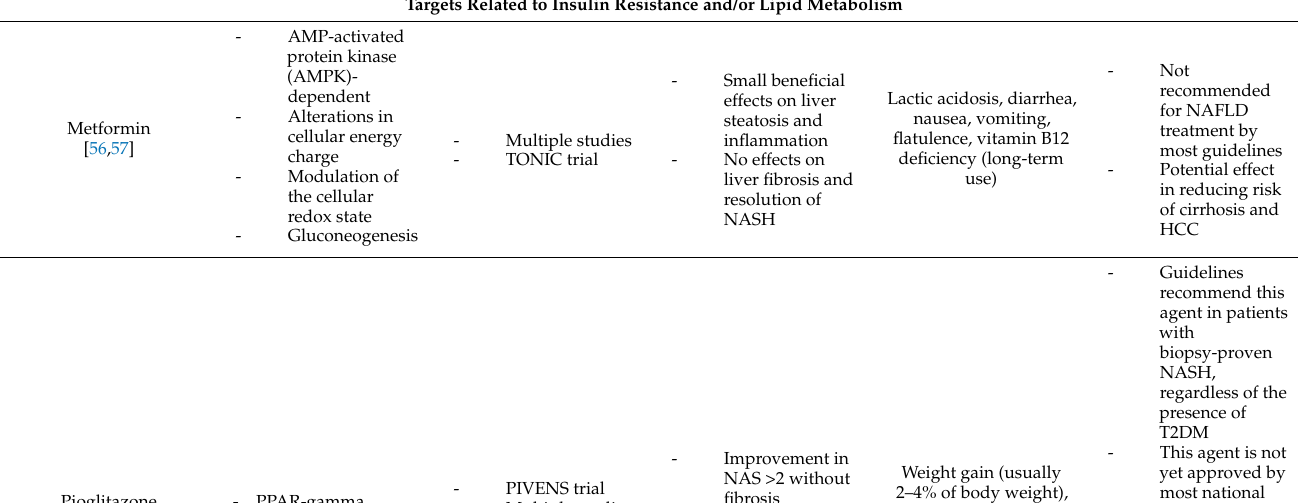
Table 2. Main agents and their characteristics for treating NAFLD and its advanced forms. Agents,